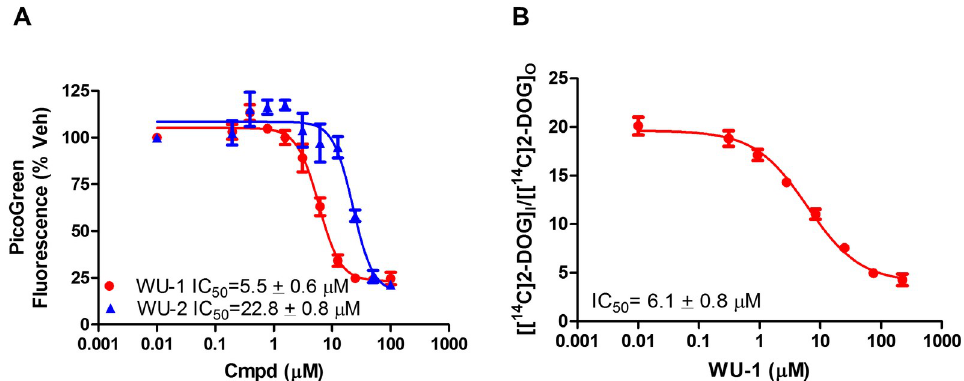
Fig 4. Inhibition of growth and IC 50 determination of glucose uptake by isolated P . falciparum parasites. A) IC 50 s for inhibition of growth of P . falciparum strain 3D7 intraerythrocytic forms by each compound were determined via a growth inhibition assay as described in Materials and Methods. Data are expressed as means ± SEMs of three independent experiments performed in duplicate. B) Uptake of 2-DG by isolated P . falciparum trophozoites at increasing concentrations of WU-1. Distribution ratios (i.e., the ratio of intracellular concentration of radiolabel relative to the extracellular concentration) were calculated as described previously [23, 50]. IC 50 s were calculated using nonlinear regression analysis (GraphPad Prism 6.0). Uptake data are expressed as means ± SEMs of three independent experiments performed in triplicate.